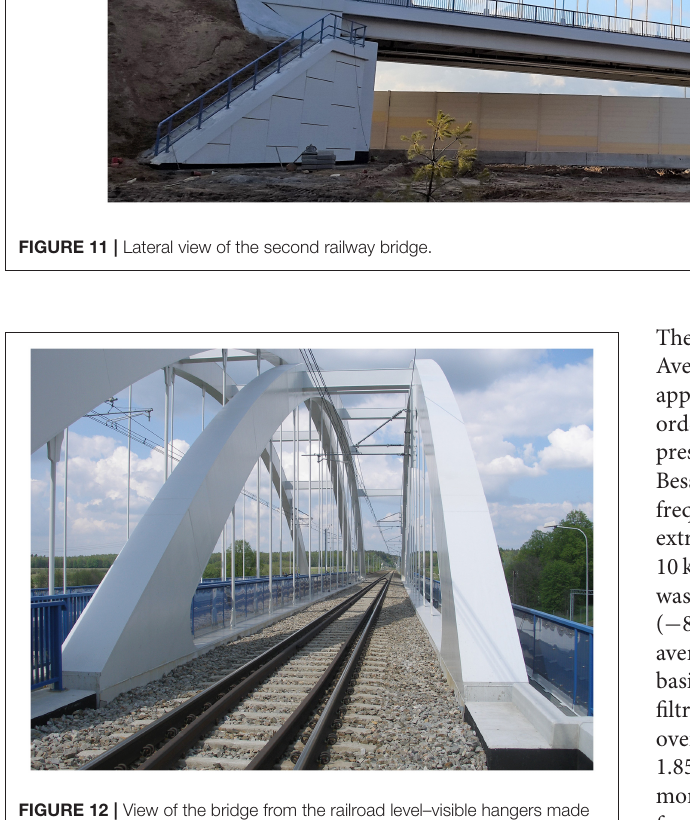
FIGURE 12 | View of the bridge from the railroad level–visible hangers made from steel